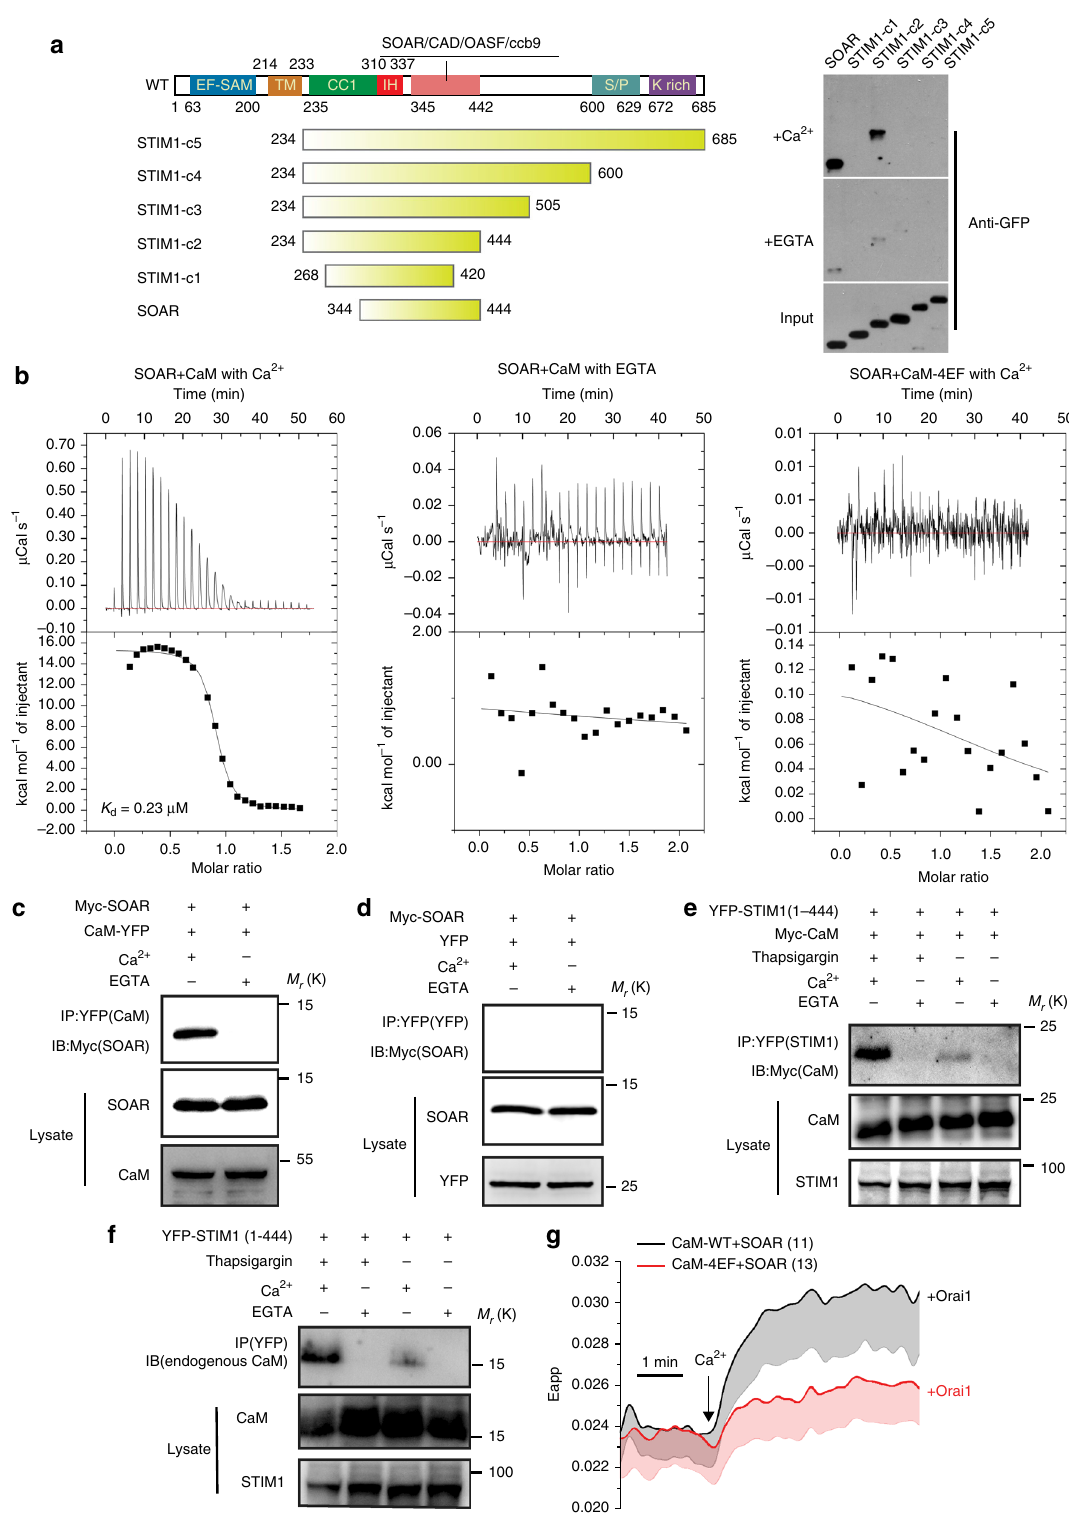
Fig. 1 Ca 2+ -CaM interacts with SOAR. a CaM-Sepharose pull-down of various STIM1 fragments in the presence of Ca 2+ or EGTA. b The dissociation constant between SOAR and CaM WT or CaM-4EF mutant in the presence of Ca 2+ or EGTA, determined by ITC. c , d Western blot analysis of co- immunoprecipitated CaM-YFP or YFP control with Myc-SOAR. Orai1 is not overexpressed in the cell. e , f Western blot analysis of co-immunoprecipitated YFP-STIM1(1 – 444) with overexpressed Myc-CaM or endogenous CaM. Orai1 is not overexpressed in the cell. g FRET between CaM-CFP or CaM-4EF-CFP (donor) and SOAR-YFP (acceptor) that are co-expressed with Myc-Orai1 in HEK293T cells. Ca 2+ was added to induce Ca 2+ in fl ux. The number of analyzed cells is indicated. Error bars denote